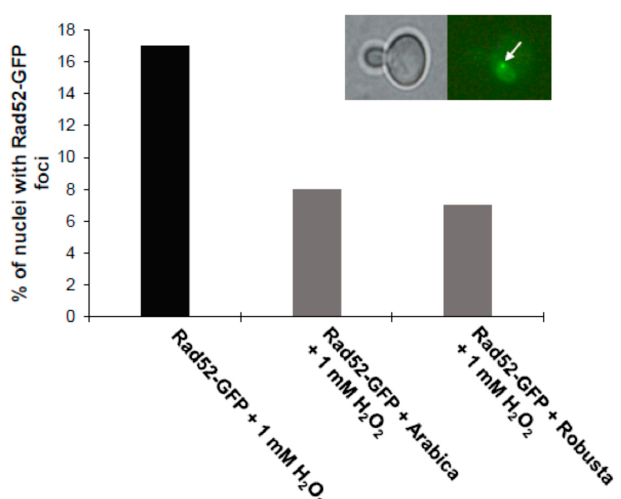
Figure 5. Induction of nuclear Rad52-GFP foci by 1 mM hydrogen peroxide. A sample photo of the Rad52-GFP is presented at the top (white arrow in the figure’s caption indicate foci). The results represent values for cells tested in two independent experiments (a total of 200 cells). Fluorescence pictures were taken with an Olympus BX-51 microscope equipped with a DP-72 digital camera and cellSens Dimension software (1000× magnification).